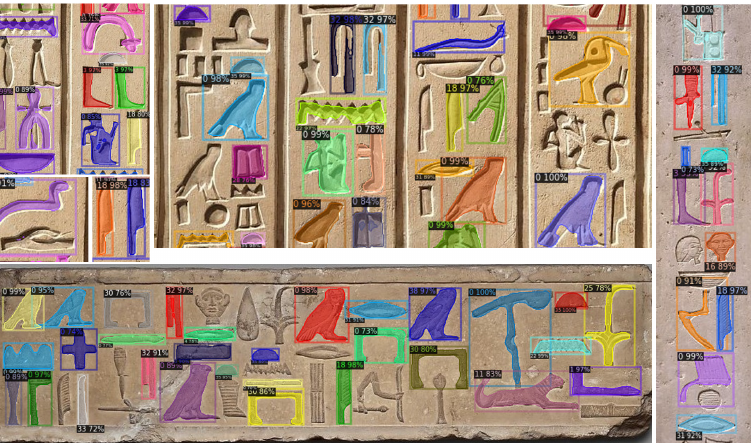
Figure 8. Examples of segmentation on stones. Cat. numbers DP253181, EG548). Credits to the MET collection